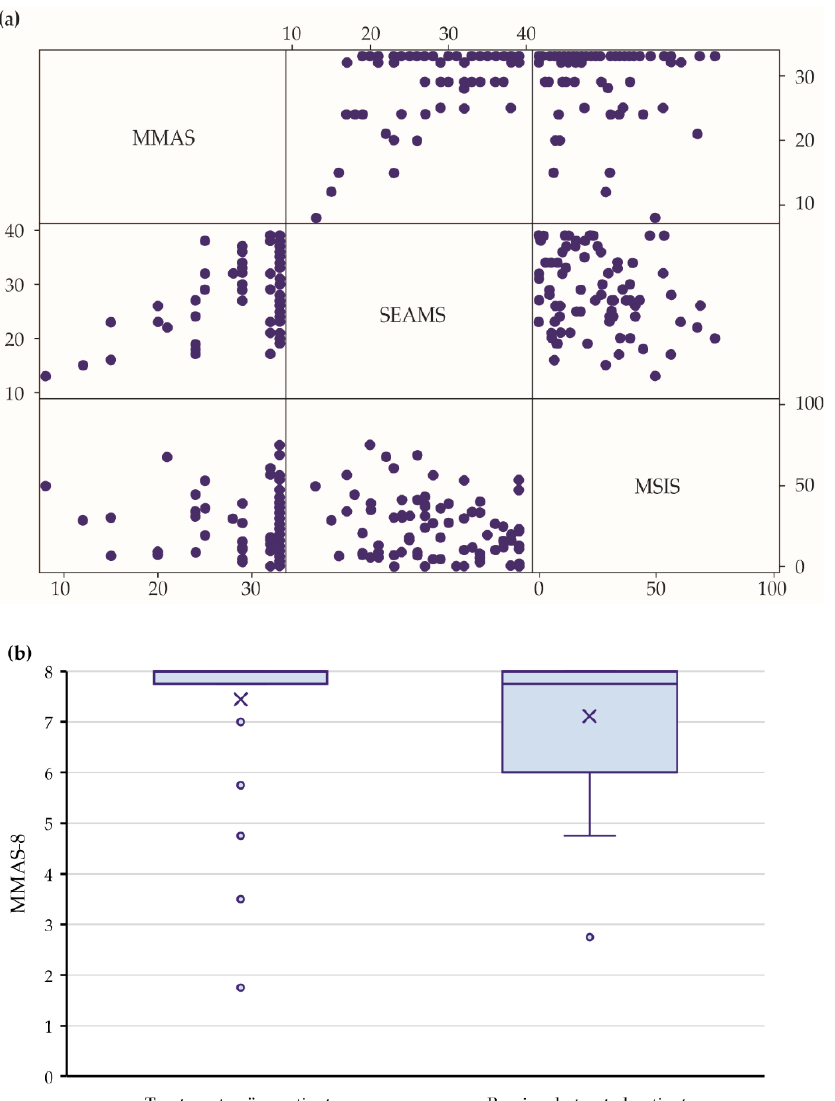
Figure 3. Questionnaire scores relevant to the primary aim after 9 months of treatment (N = 82). ( a ) Matrix showing observed two-dimensional relationships between patient adherence (MMAS- 8), Self-Efficacy in Medication Use (SEAMS), and quality of life (MSIS-29) at 9 months (visit 3). ( b ) The difference in adherence (MMAS- 8) between treatment -naïve and previously treated patients at 9 months (visit 3).